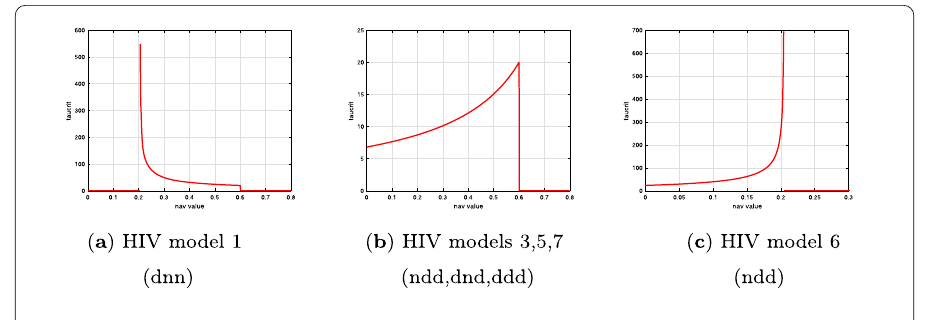
Figure 9 Plots of critical delay vs antiviral infectiousness